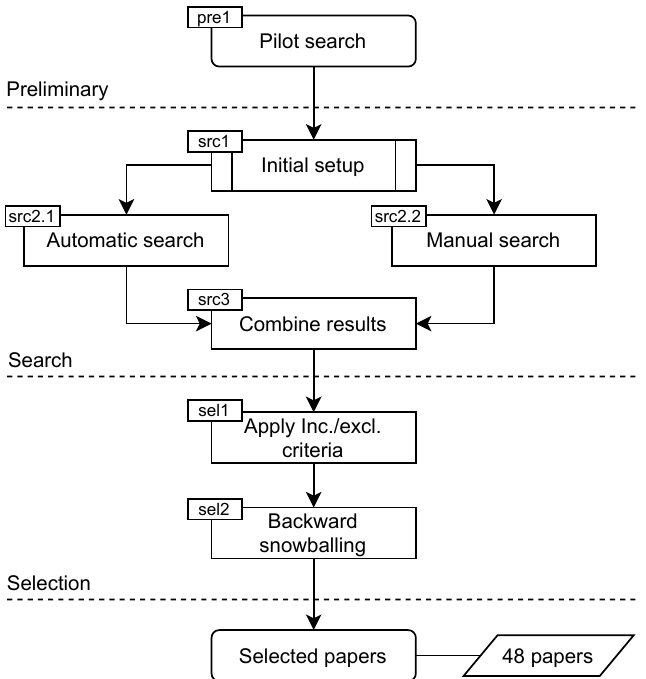
Figure 3. Search and selection process of our SMS. We started with a pilot search as a preliminary step. Then, we conducted the main automatic and manual search. Lastly, we selected the relevant